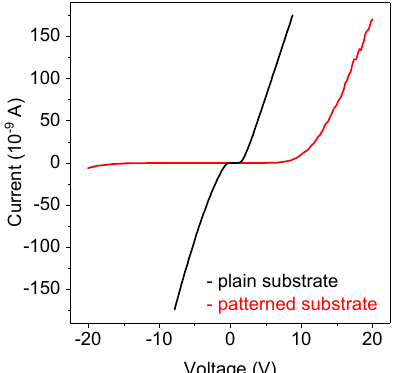
Figure 4. I – V characteristics of single nanorod n -ZnO/ p -GaN heterojunctions that were fabricated on both the plain and FIB-patterned substrates. The patterned structure exhibits a rectifying diode-like I – V characteristic. The plain structures show a nonlinear almost symmetrical I – V characteristic.